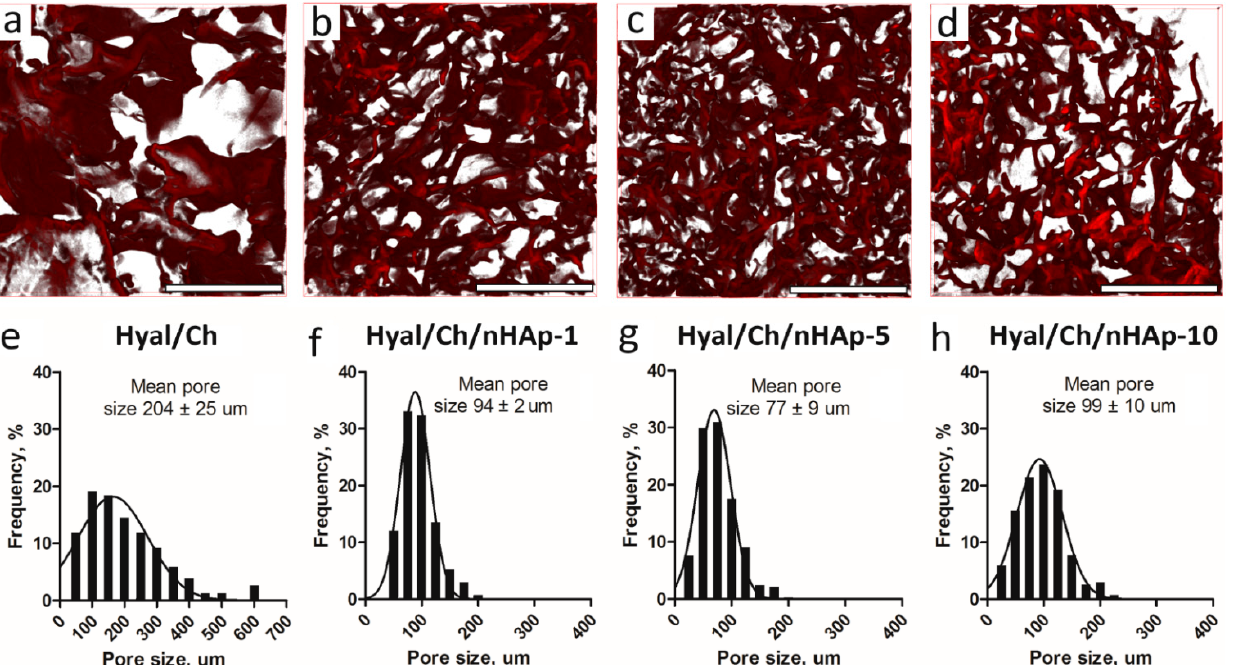
Figure 3. CLSM images ( a – d ) and the pore size distributions ( e – h ) in the swollen macroporous hy- aluronic acid/chitosan hydrogel samples. Hyal/Ch sample was without hydroxyapatite nanoparti- cles ( a , e ); Hyal/Ch/nHAp-1 ( b , f ), Hyal/Ch/nHAp-5 ( c , g ) and Hyal/Ch/nHAp-10 ( d , h ) samples were loaded with 1, 5 and 10 wt. % of nanoparticles, respectively. Scale bar is 500 μ m.